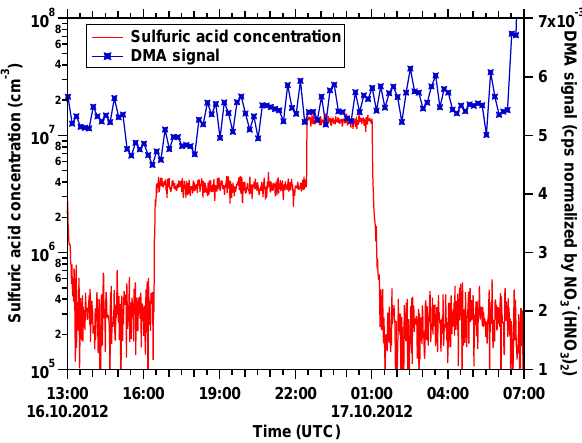
Figure 7. The time series of the normalized DMA signal and the [H 2 SO 4 ] are shown for a typical CLOUD7 run. The fig- ure demonstrates that the DMA signal does not change signif- icantly when H 2 SO 4 is added even when the [H 2 SO 4 ] reaches ∼ 1.5 × 10 7 moleculecm − 3 . The DMA mixing ratio shown here is 46 ± 12pptv, which was measured by the IC